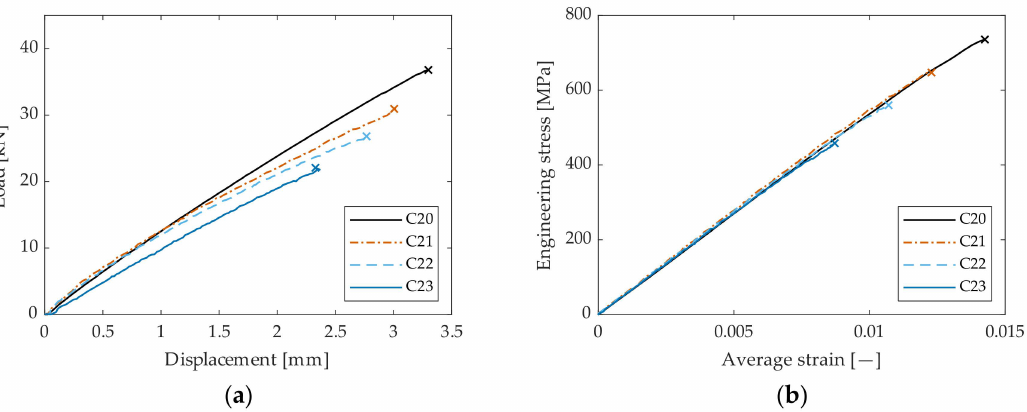
Figure 5. ( a ) Load-displacement plot for the four types of specimens. ( b ) Surface average stress and strains of the tested specimen. Engineering stress value is computed using the gross section of the specimen, and strain value is the average over the whole DIC area of interest. Refer to Table 1 for an explanation of the labels.